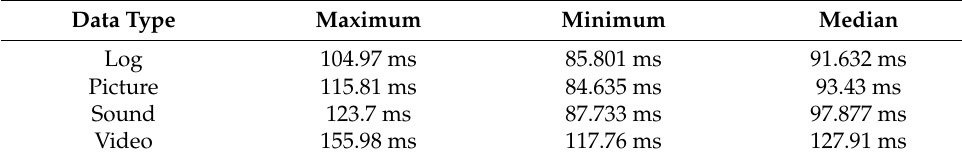
Table 6. IPFS Upload